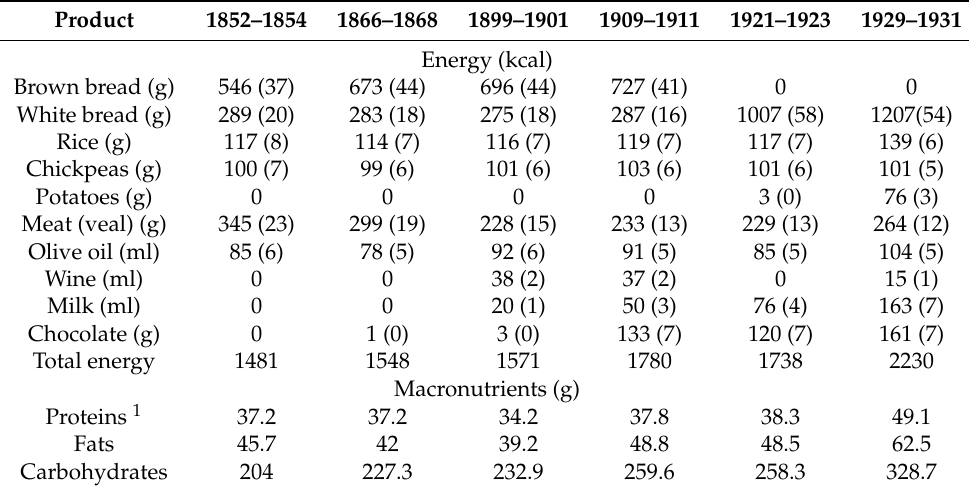
Table 3. Daily intake of energy and macronutrients of foundlings in the Hospital General de Valencia,